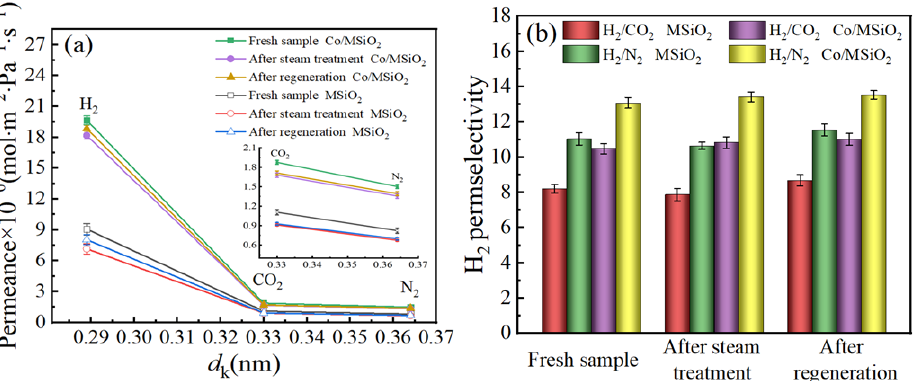
Figure 12. Effect of hydrothermal conditions on the ( a ) permeance of H 2 and ( b ) perm-selectivities of H 2 for supported MSiO 2 membrane and supported Co/MSiO 2 membrane with n Co = 0.08 at a pressure difference of 0.2 MPa and 200 °C.